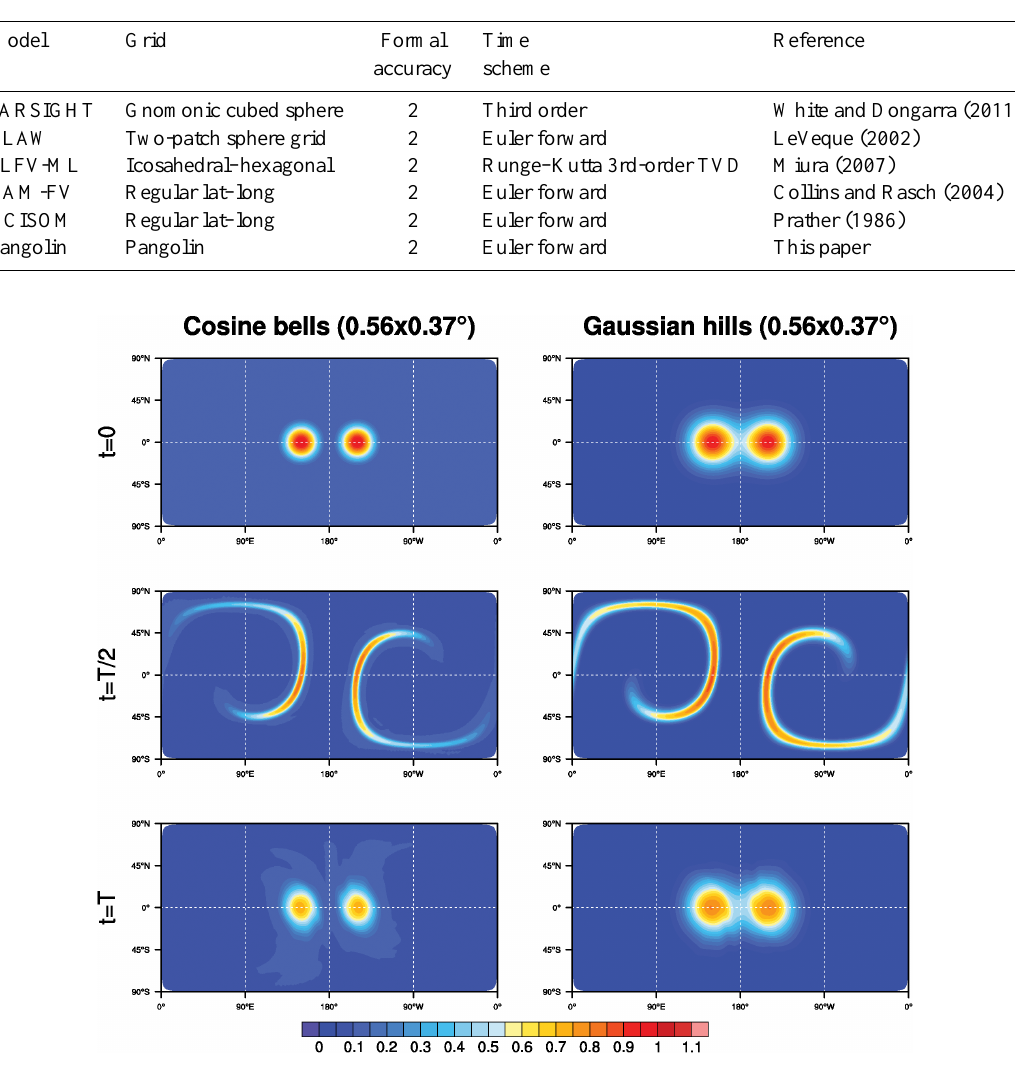
Figure 7. Cosine bells and Gaussian hills results for t = 0, t = T/ 2, t = T (top to bottom) with Pangolin. The initial distribution is first deformed into filaments and then advected back to its initial position. The Equator resolution is 0 . 56 ◦ × 0 . 37 ◦ . For these plots, Pangolin data are interpolated to a regular latitude–longitude